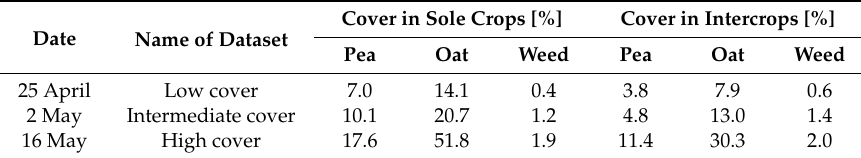
Table 1. Mean values of the canopy cover of pea, oat, and weed in sole crops and intercrops for the three datasets.